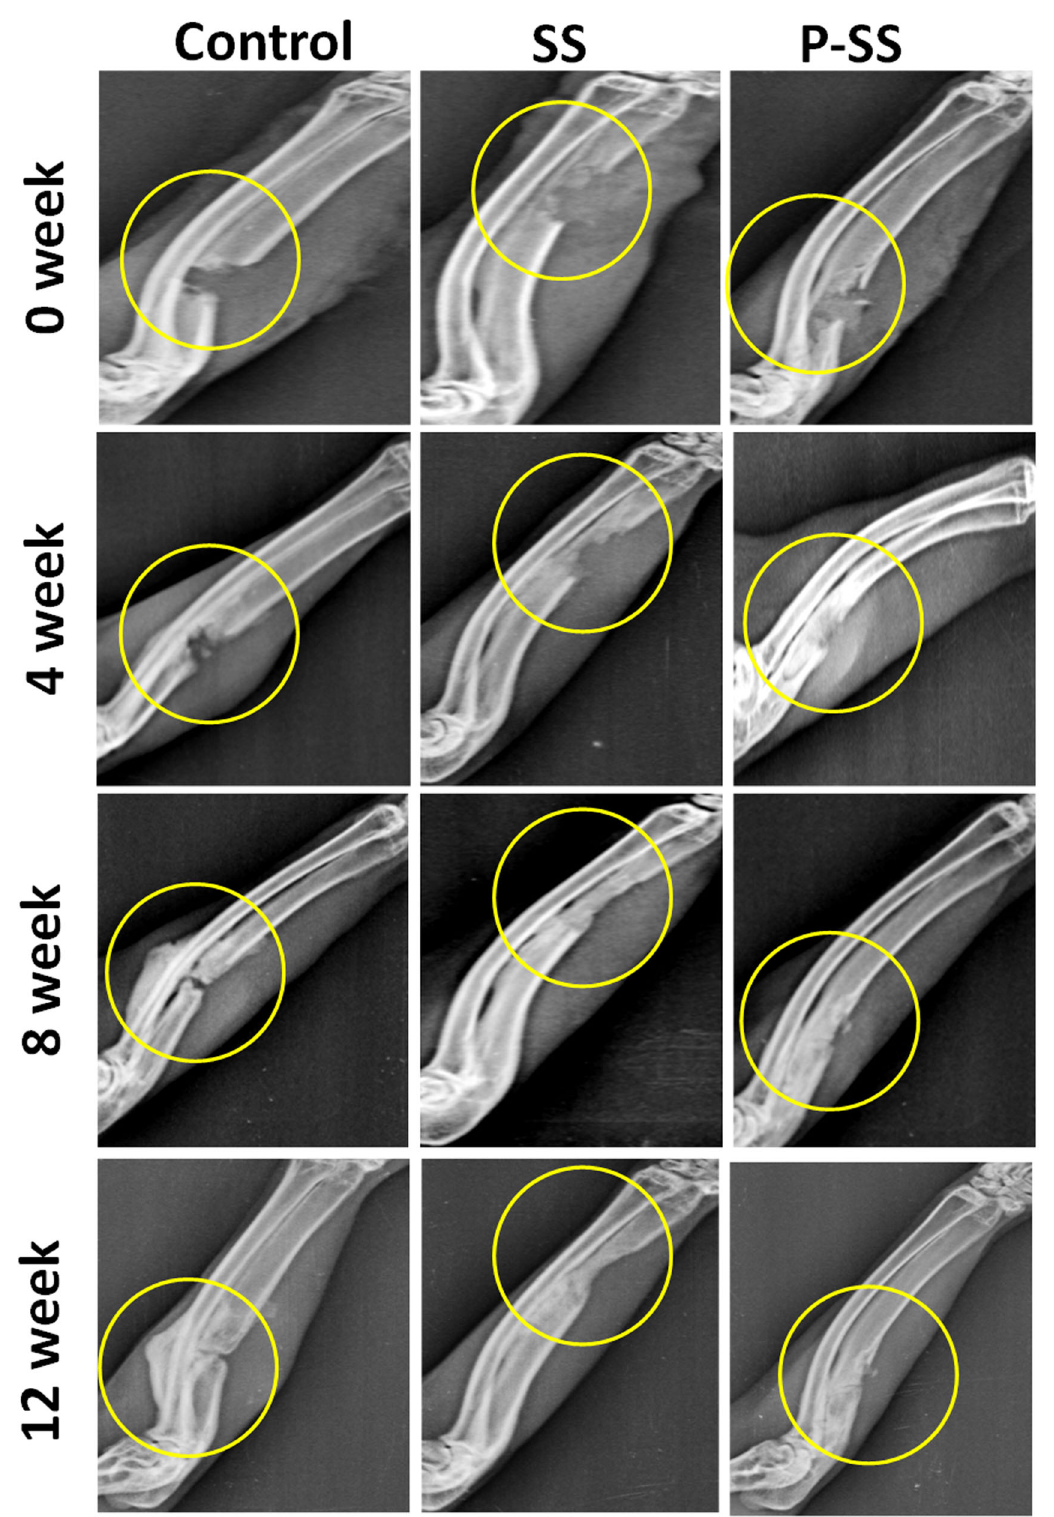
Fig. 5 Radiographic analysis of control, SS and P-SS treated rabbit ulnar bone defects after 0, 4, 8, and 12 weeks of surgery. Circles indicate defect regions with new bone